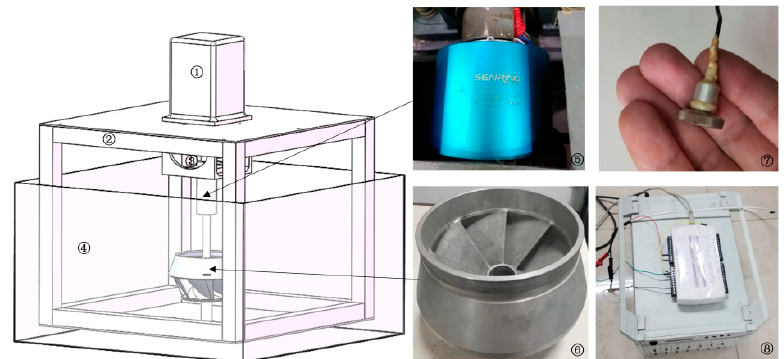
Figure 1. Schematic diagram of the test bench. (1. Motor, 2. Frame, 3. Bearing, 4. Tank, 5. Slip ring, 6. Impeller, 7. Piezoelectric accelerometer, 8. Charge amplifier and NI Data Acquisition Card).